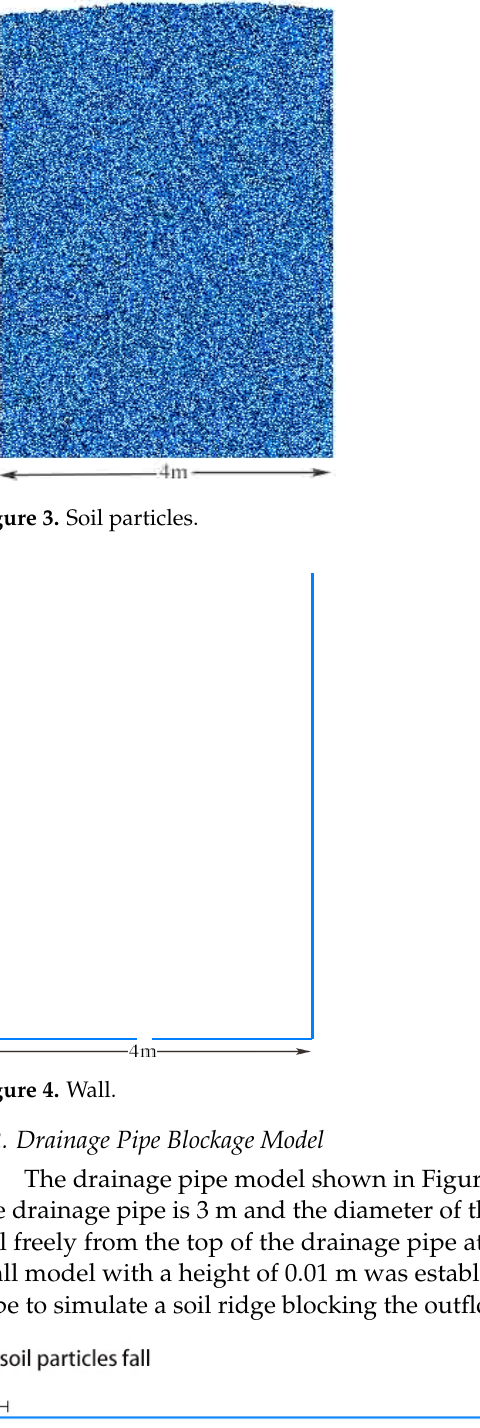
Table 2. The content of each particle size of soil.